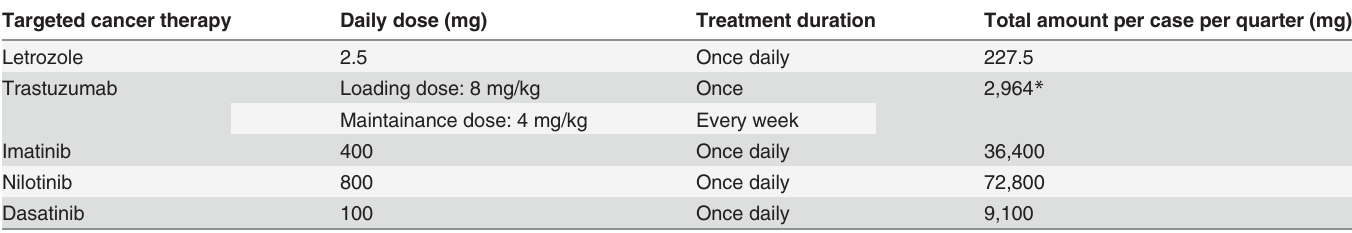
Table 1. Standard treatment of targeted cancer